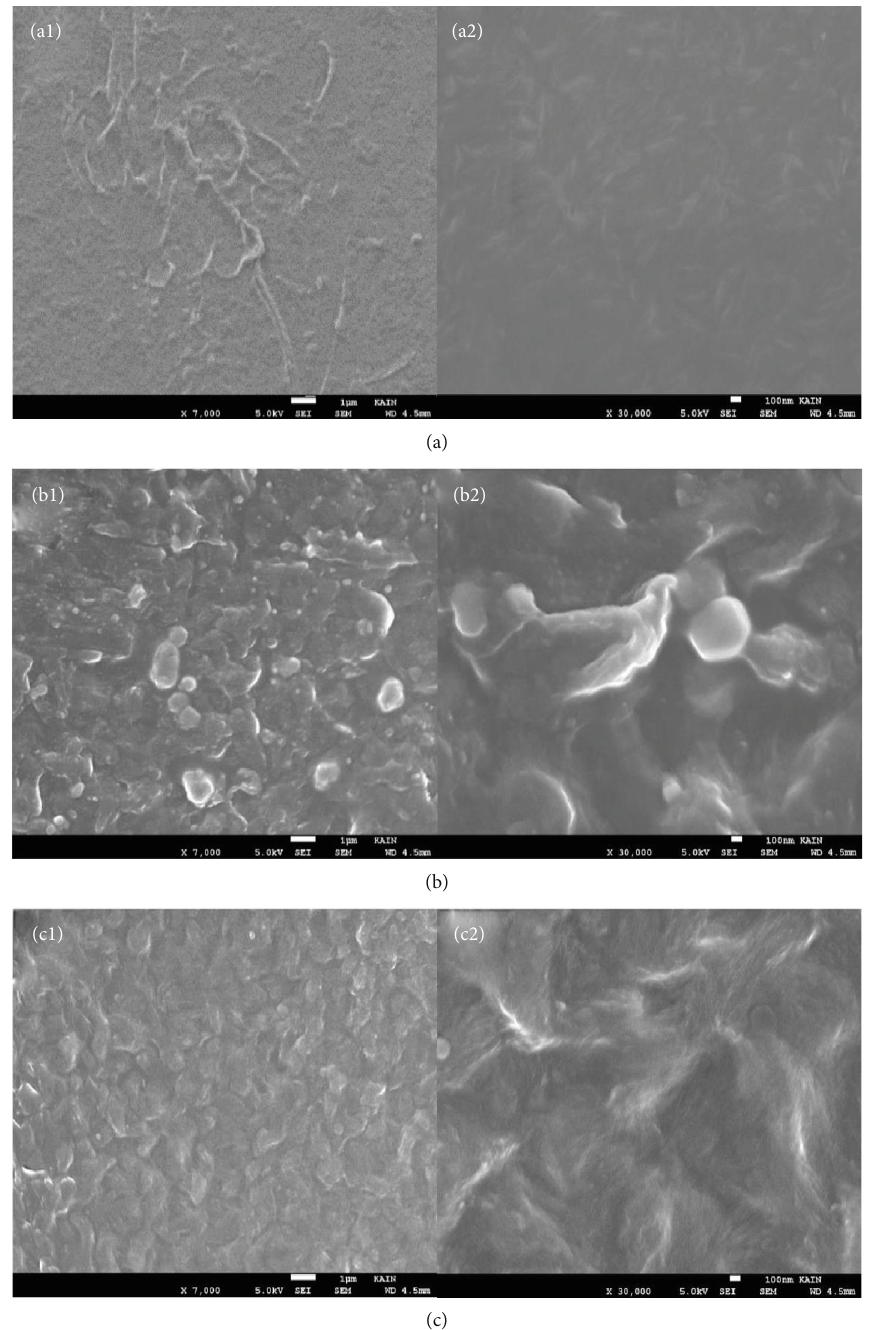
Figure 5: SEM images of (a1) neat PE at low resolution and (a2) neat PE at high resolution, (b1) PEC4 composite at low resolution and (b2) PEC4 composite at high resolution, and (c1) PEC8 composite at low resolution and (c2) PEC8 composite at high